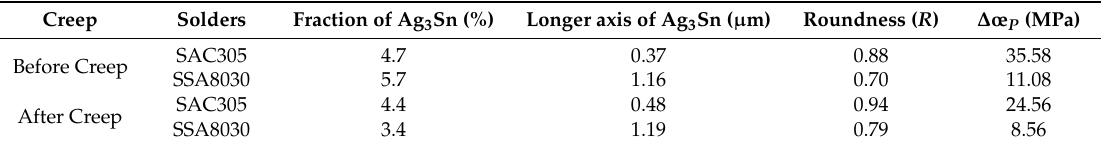
Figure 9. Intermetallic compounds before and after creep testing at 175 °C, respectively, for ( a , c ) SAC305 and ( b , d ) SSA8030 solders. Table 2. Size and shape of Ag 3 Sn in eutectic microstructure before and after creep test.